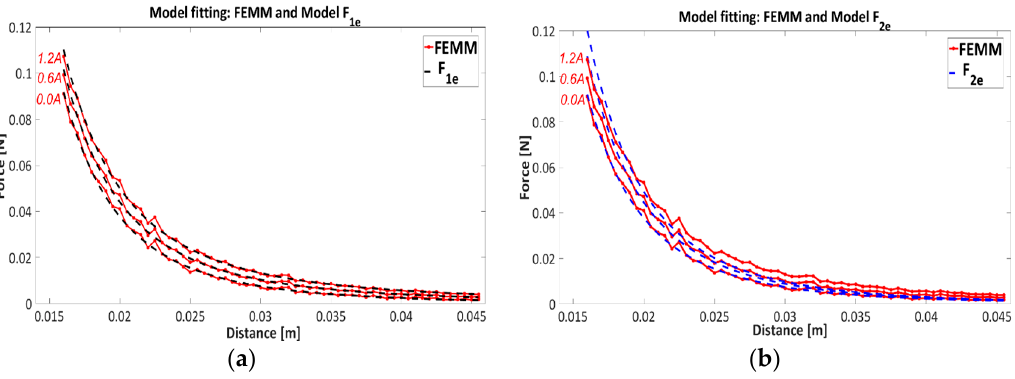
Figure 9. Comparison of model fitting with models F 1 e —( a ) and F 2 e —( b ) on current characteristics 0 A,0.6 A and 1.2 A .